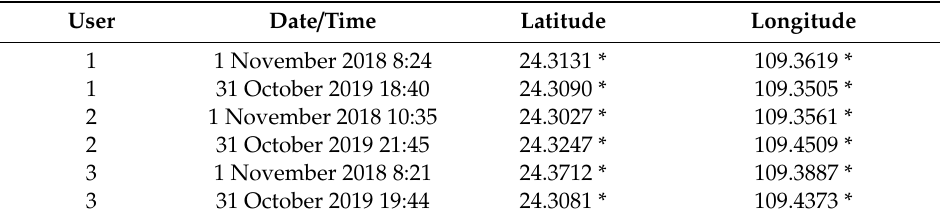
Table 1. Trajectory dataset of the three users.